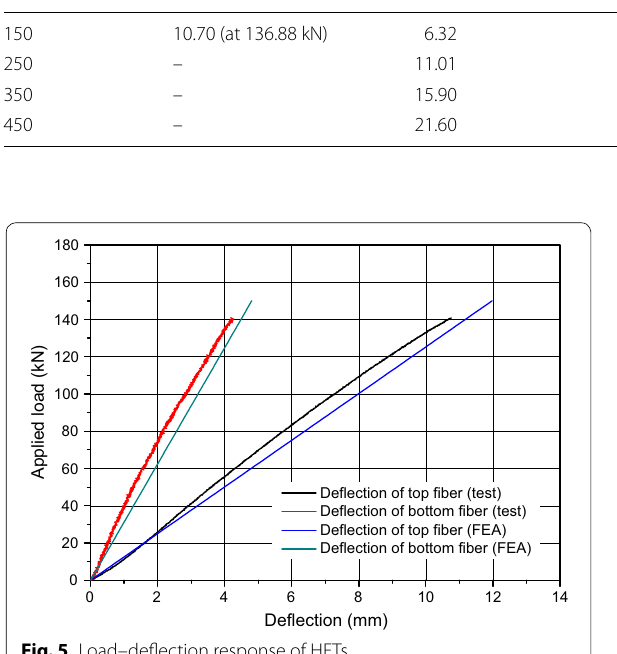
Fig. 5 Load–deflection response of HFTs.